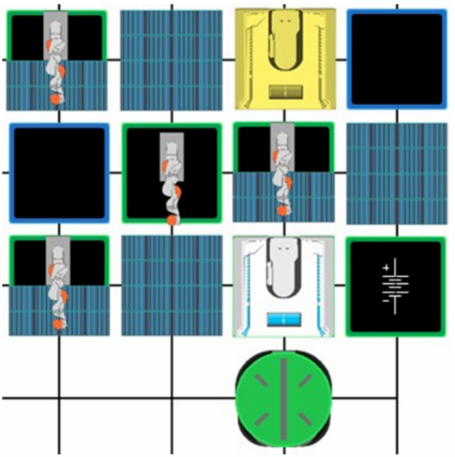
Figure 9. Manufacturing island without direct access to modular platforms.